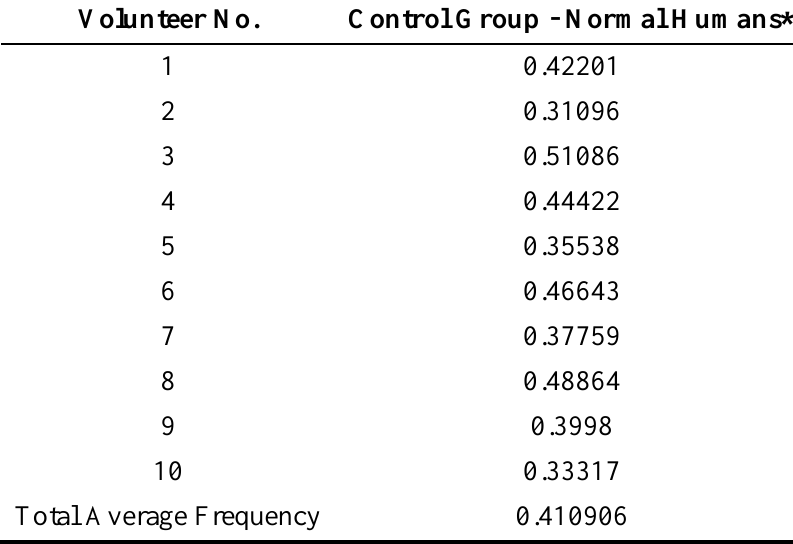
Table 5. Dorsum manus resting tremor frequency of the control group (normal human).